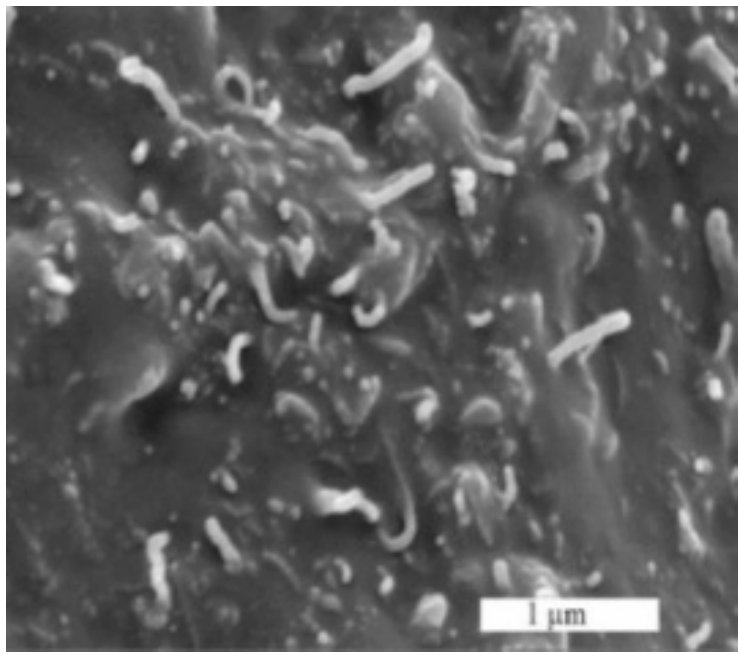
Figure 1. An SEM image of the MWCNT/EOC composite cross-section. The bright spots represent individual MWCNTs, which protruded from the plane of the cross-section.